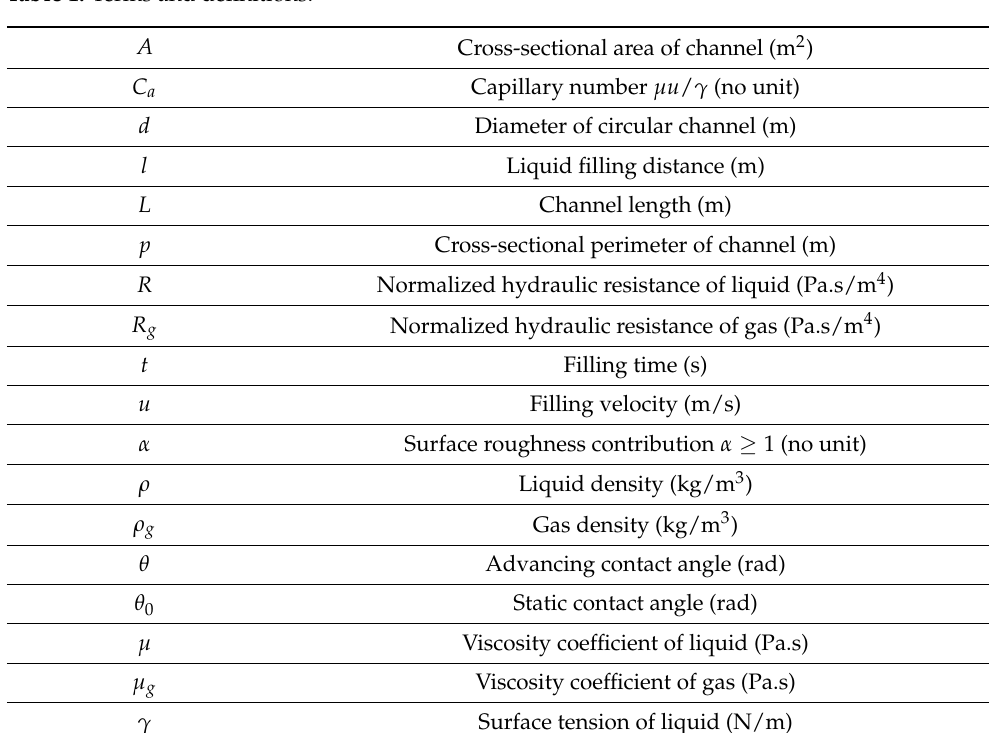
Table 1. Terms and